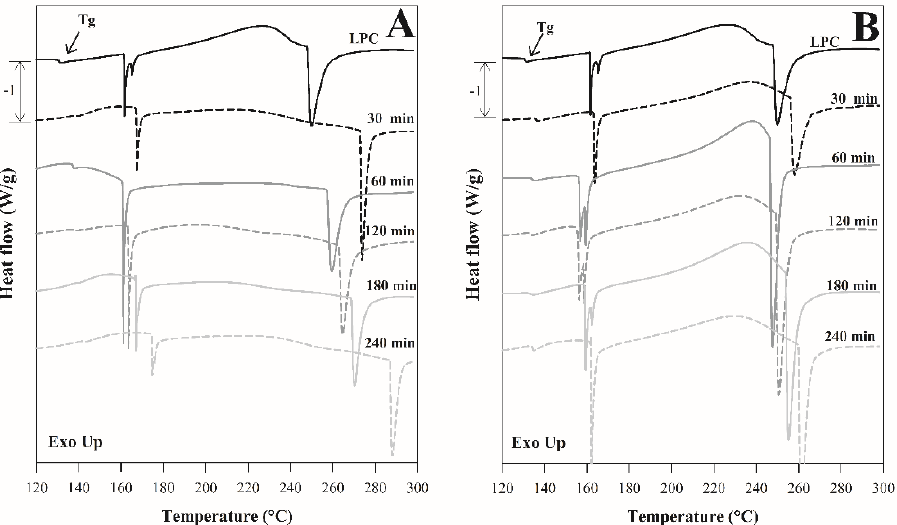
Figure 4. Curves of DSC of leaf protein concentrate (LPC) and protein hydrolysates obtained with pepsin ( A ) and pancreatin ( B ) at different hydrolysis times.